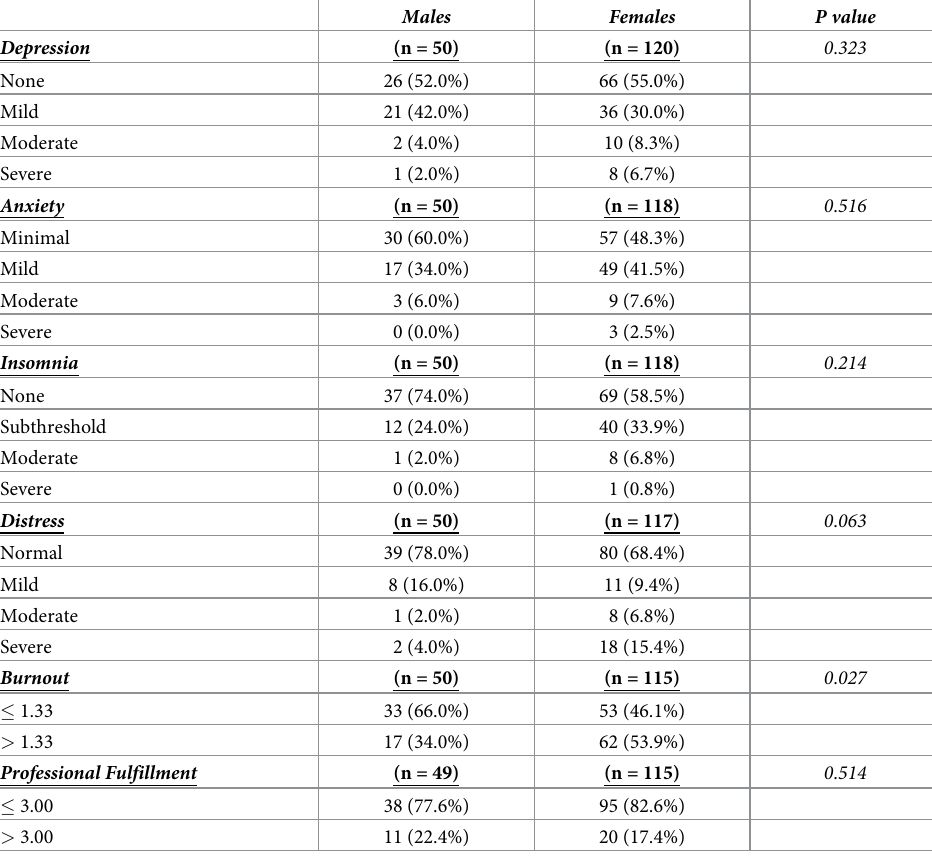
to other studies, we found over 40% of front-line nurses at our facility who took care of COVID-19 patients suffered from mild to severe depression [14, 29, 30]. Only 1.8% of the par- ticipants in our study reported ever having mental health disorders previously. To help put this into perspective, prior to COVID-19, the WHO on world mental health situation placed Kenya as the sixth most depressed country in Africa with a depression rate of 4.4% [31], while a recent study conducted by Nyongesa and colleagues found a prevalence of 13.8% of depressive symp- toms in adults living with HIV in rural Kilifi in Kenya [32]. Our study also aligns with a number of other studies showing that front-line nurses, espe- cially females, suffer from poor sleep, depression and anxiety [11, 15, 33, 34]. Furthermore, similar to a study conducted by Huang and colleagues, we also found that females nurse at our Table 2. Comparison of mental health disorders among the male and female